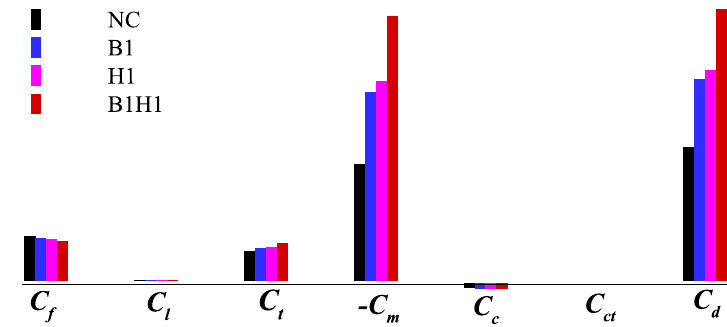
Fig. 8 Bar graph of each contribution term in C f decomposition in each